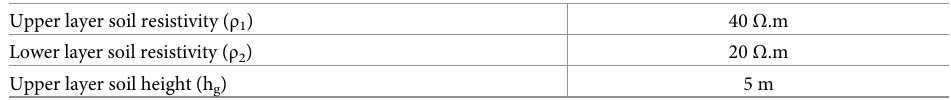
Table 6. Soil properties of horizontal two-layer soil